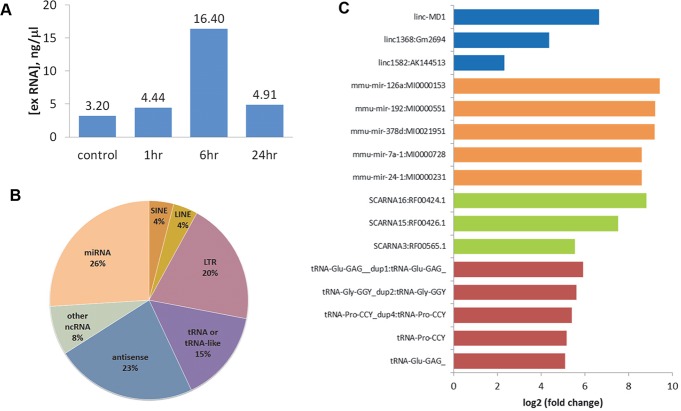
Circulating extracellular RNA (exRNA) after partial hepatectomy.(A). Serum was collected from mice at the indicated time points after partial hepatectomy, and exRNA was isolated. Total exRNA was quantitated using NanoDrop. An increase in circulating total exRNA was seen at six hours after partial hepatectomy. Bars represent average concentration of total exRNA yield from 4 separate samples. (B and C) RNA seq was performed on serum exRNA, and analysis of the serum exRNA was performed using the Maverix pipeline. Differentially-expressed extracellular non-coding RNA were determined across samples. (B) Non-coding RNA that are mapped include miRNA, tRNA, snoRNAs, antisense transcripts and repeat elements. (C). Bar chart representing the most highly differentially-expressed circulating EV non-coding RNA within selected classes six hours after partial hepatectomy. These differentially-expressed extracellular non-coding RNA are candidate biomarkers of a liver regenerative response.